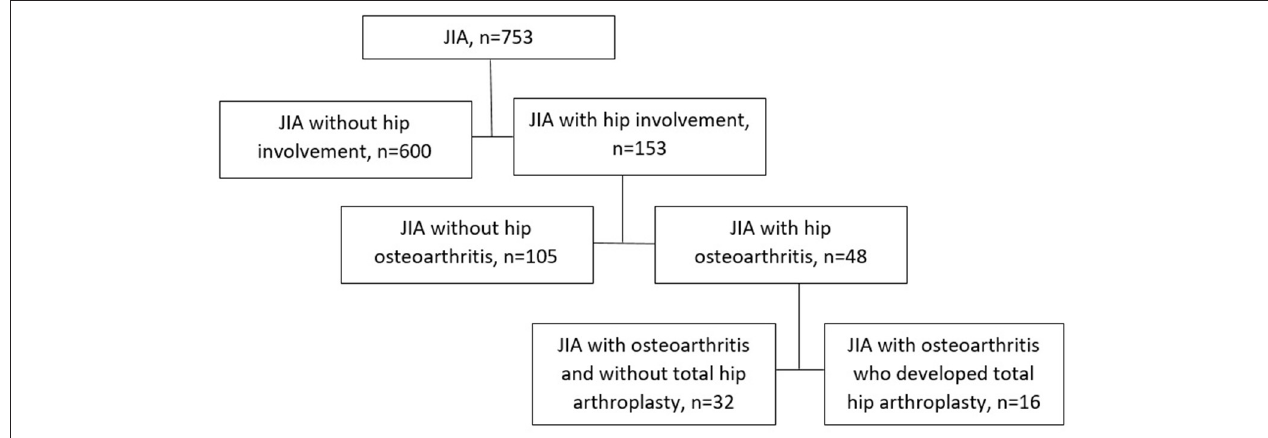
FIGURE 1 | The distribution of the enrolled patients, according to the stage of hip involvement.